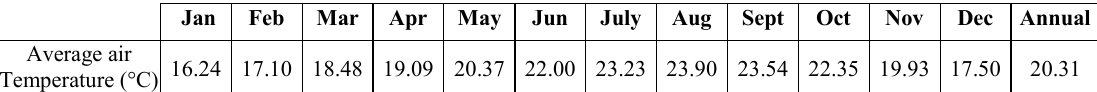
Table 1. Site meteorological data